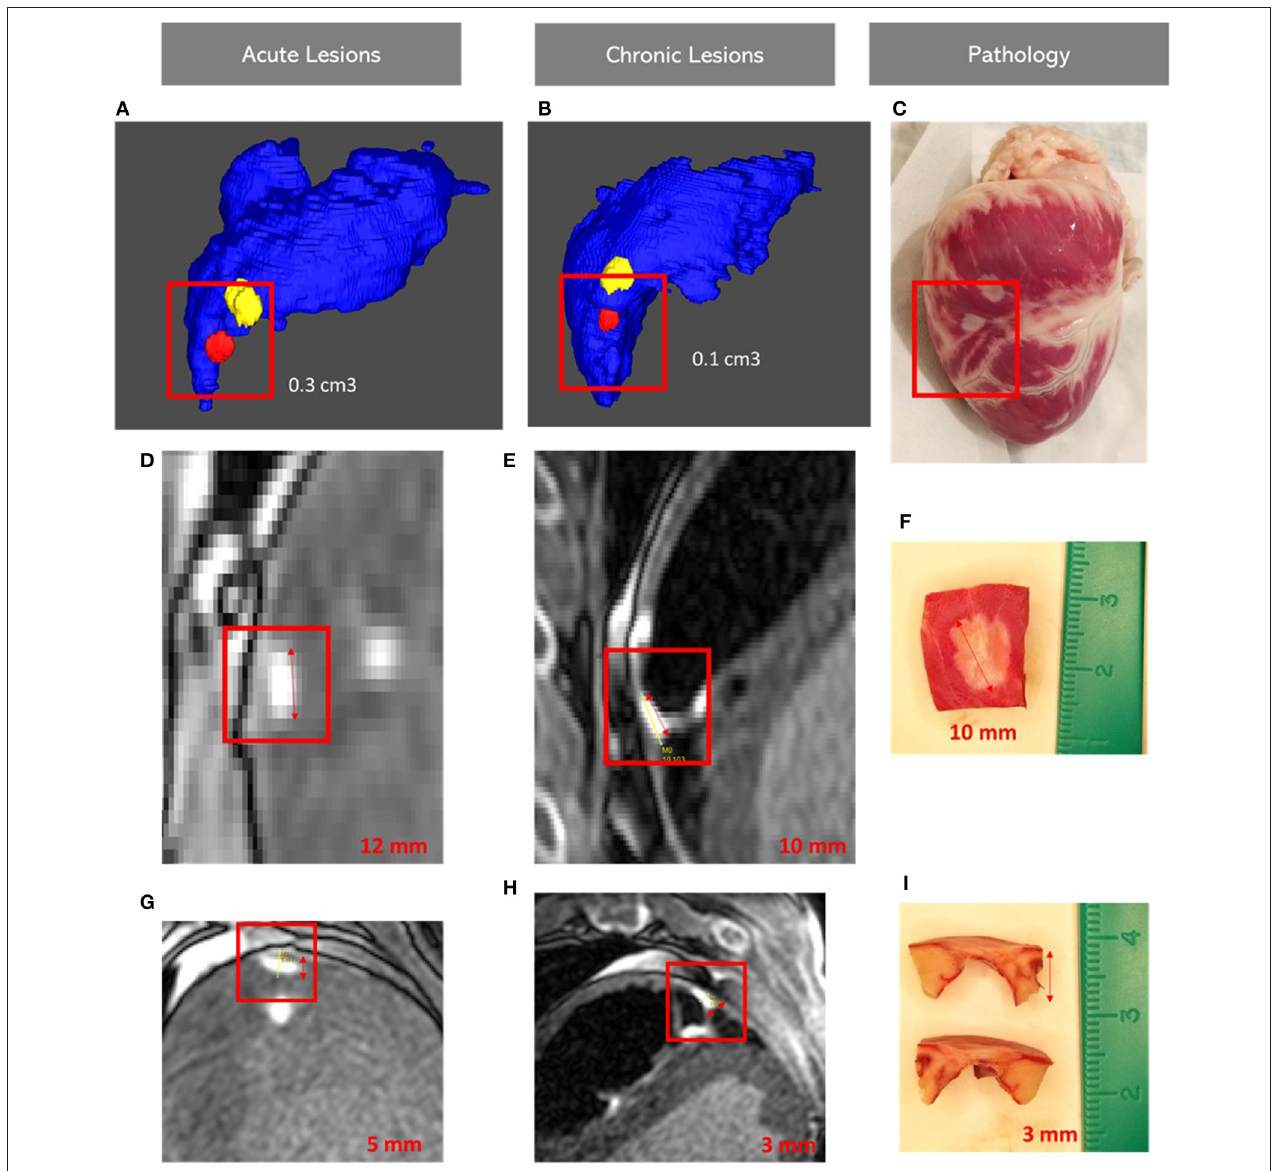
FIGURE 3 | Images showing lesion volumes in both acute and chronic phases in the right ventricular free wall: Acute (A) , Chronic corview representation (B) and on gross pathology (C) ; Acute (D,G) , Chronic LGE-MRI (E,H) and histology (F,I) . LGE-MRI: Late Gadolinium Enhancement Magnetic Resonance Imaging.